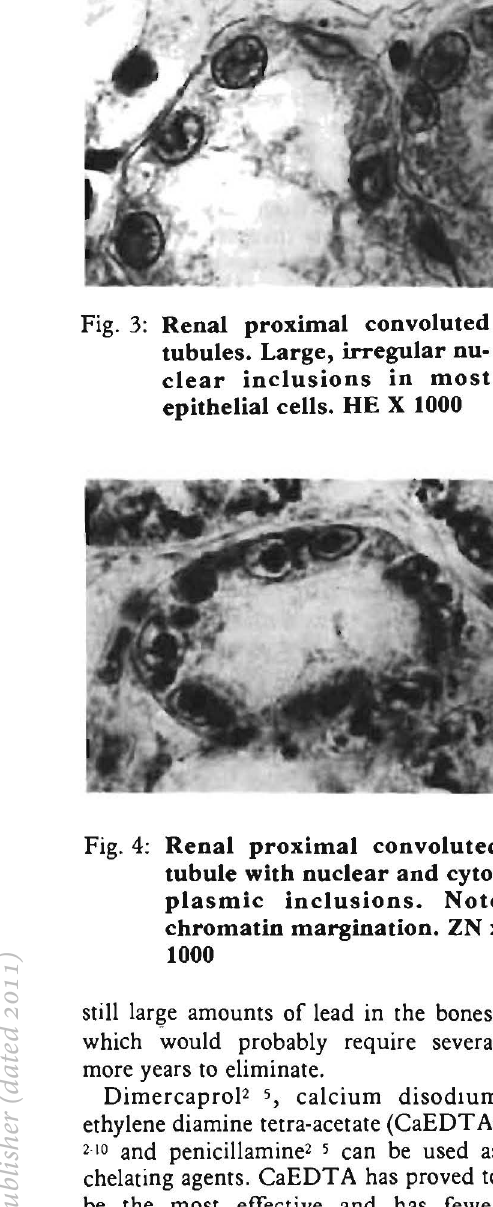
Fig. 4: Renal proximal convoluted tubule with nuclear and cyto plasmic inclusions.